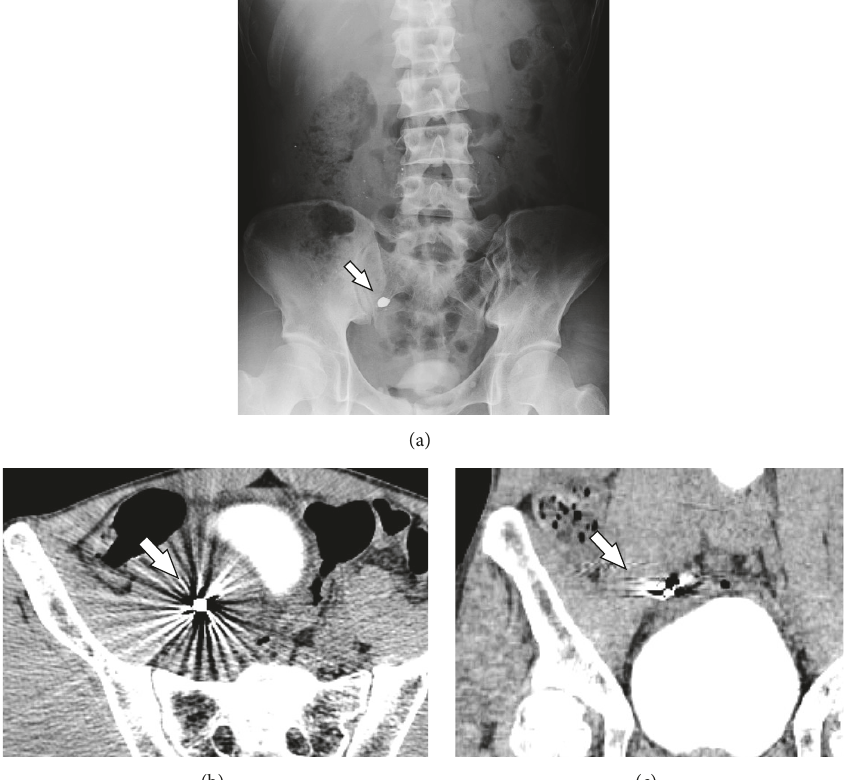
Figure 1: Abdominal X-ray examination. Radiopaque object consistent with a metallic foreign body in the right lower quadrant of the abdomen (a). Retained barium with strong artifact on axial (b) and coronal (c) views on abdominal